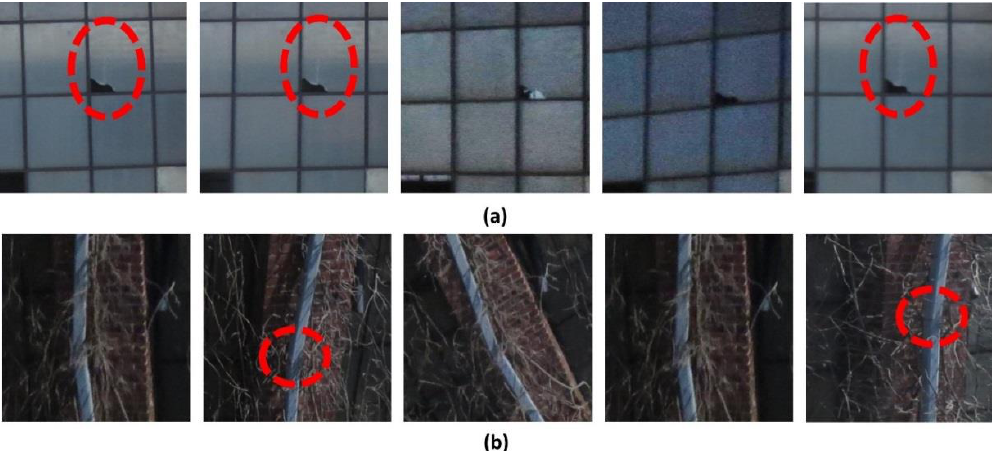
Figure 8. Localized ROIs corresponding to TRI 1 in ( a ) and TRI 2 in ( b ): The hairline vertical crack on a window pane in TRI 1 and damage on a drainage pipe in TRI 2 are only visible in specific ROIs and those damage locations are marked with a red dotted line.